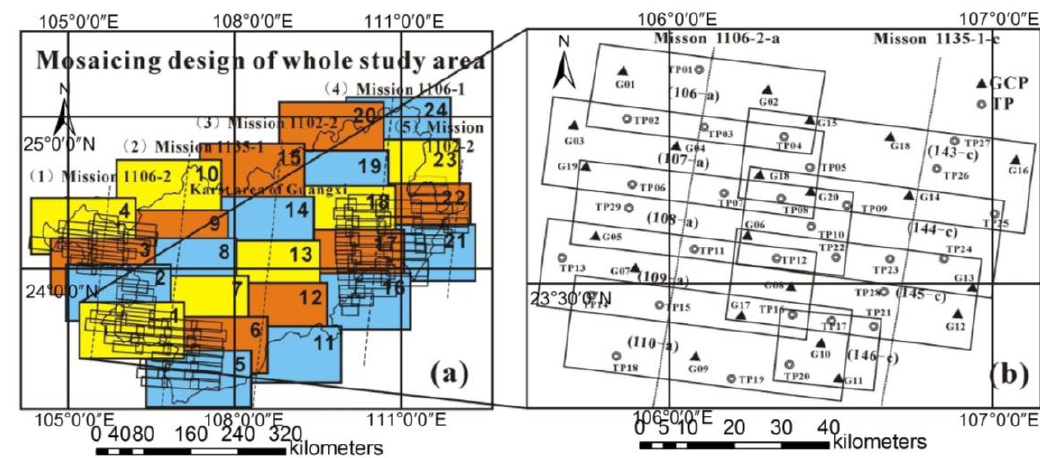
Figure 7. The polynomial block adjustment: ( a ) Design of polynomial block adjustment in the entire area, which is divided into 24 blocks; ( b ) One block, which is used to explain establishment of the observation equations.